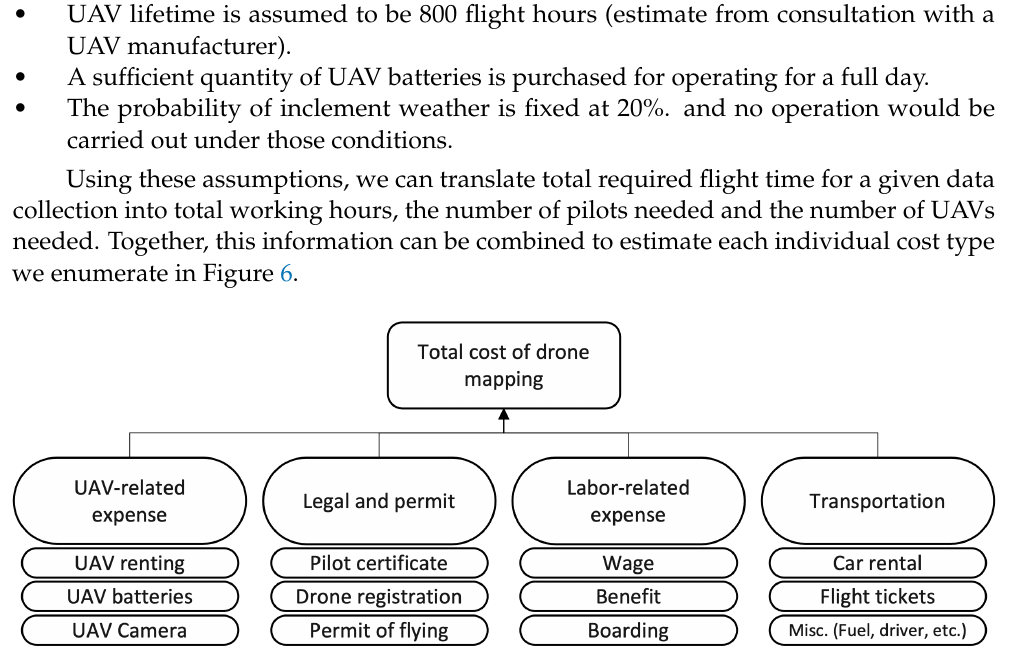
Figure 6. Major categories of our UAV operation cost estimate structure. Legal and permitting cost is highly region-dependent and is usually a fixed cost that is not dependent on the resolution and area covered. All other categories are highly resolution-area